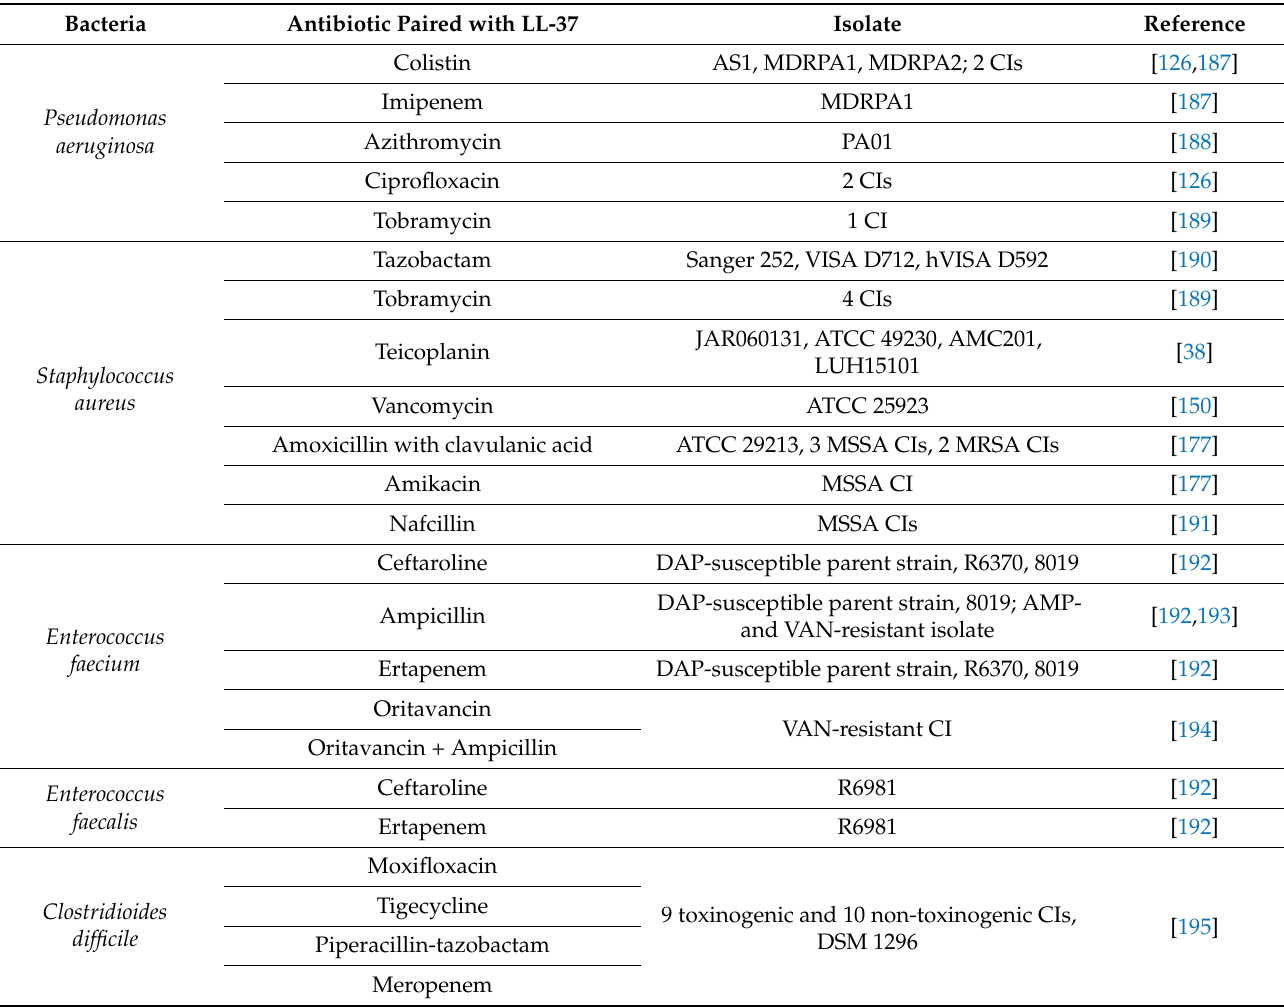
Table 3. Combinations of LL-37 and antibiotics that show synergistic effects against specific pathogens. Bacteria Antibiotic Paired with LL-37